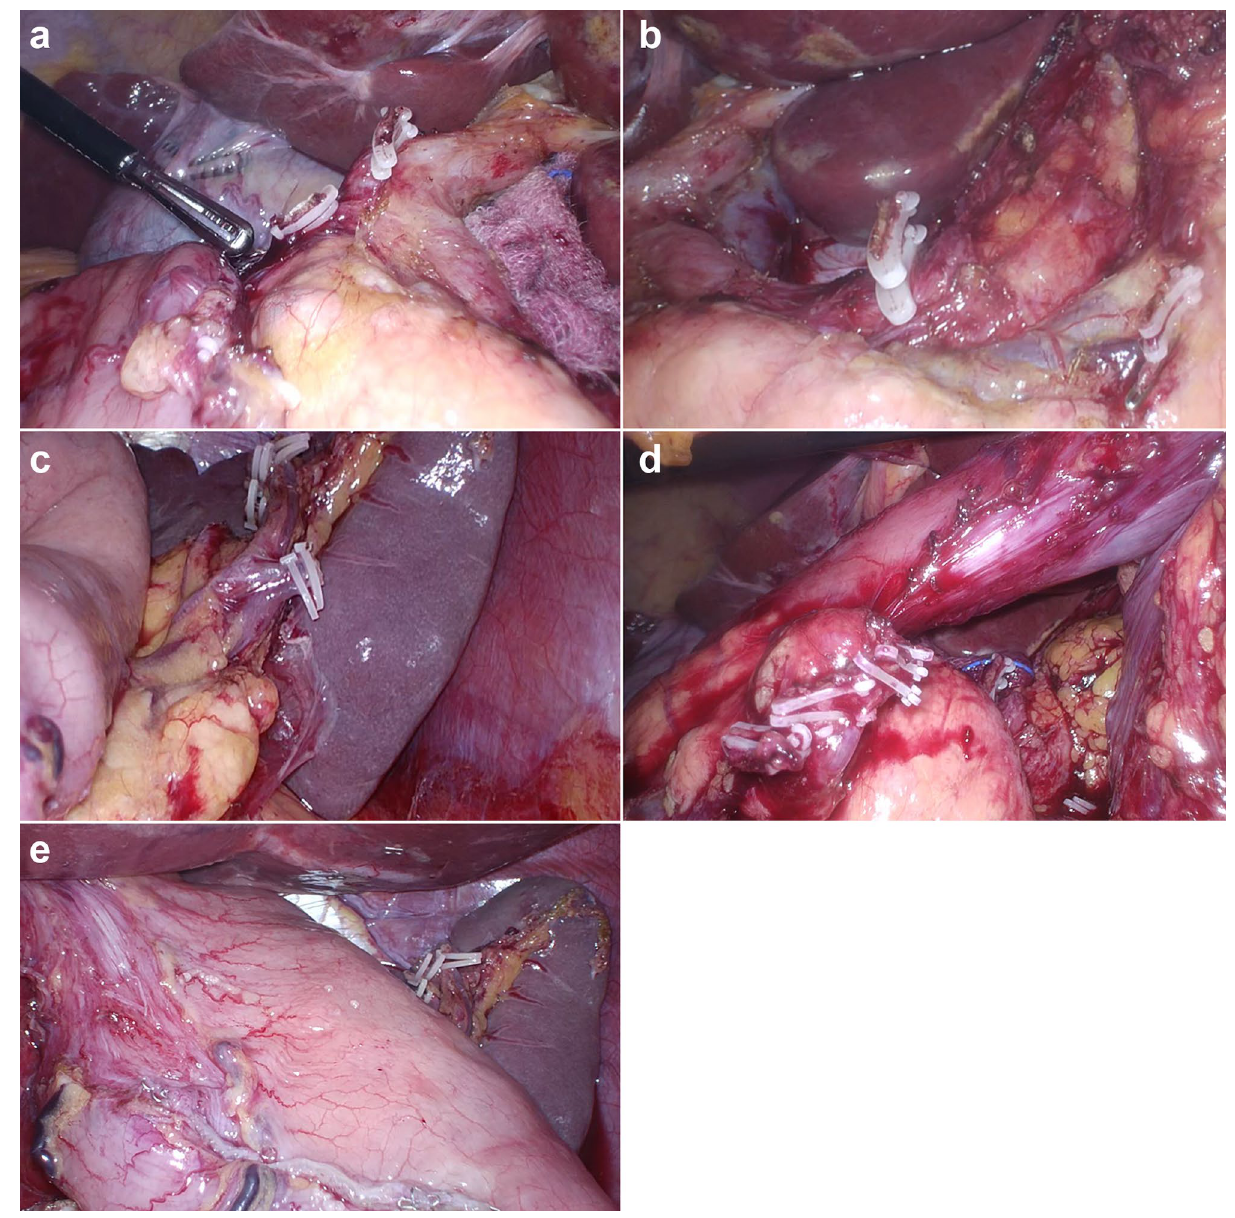
Figure 1. The surgical field of D2 lymph node dissection during reduced-port totally laparoscopic gastrectomy. (a) Ligated right gastric artery and supraduodenal artery (station no. 5). (b) Ligated left gastric artery and posterior gastric artery (station no. 7, 8a, 9, 11p). (c) Ligated left gastroepiploic artery (station no. 4sb). (d) Ligated right gastroepiploic artery (station no. 6). (e) Dissection of station no. 1,